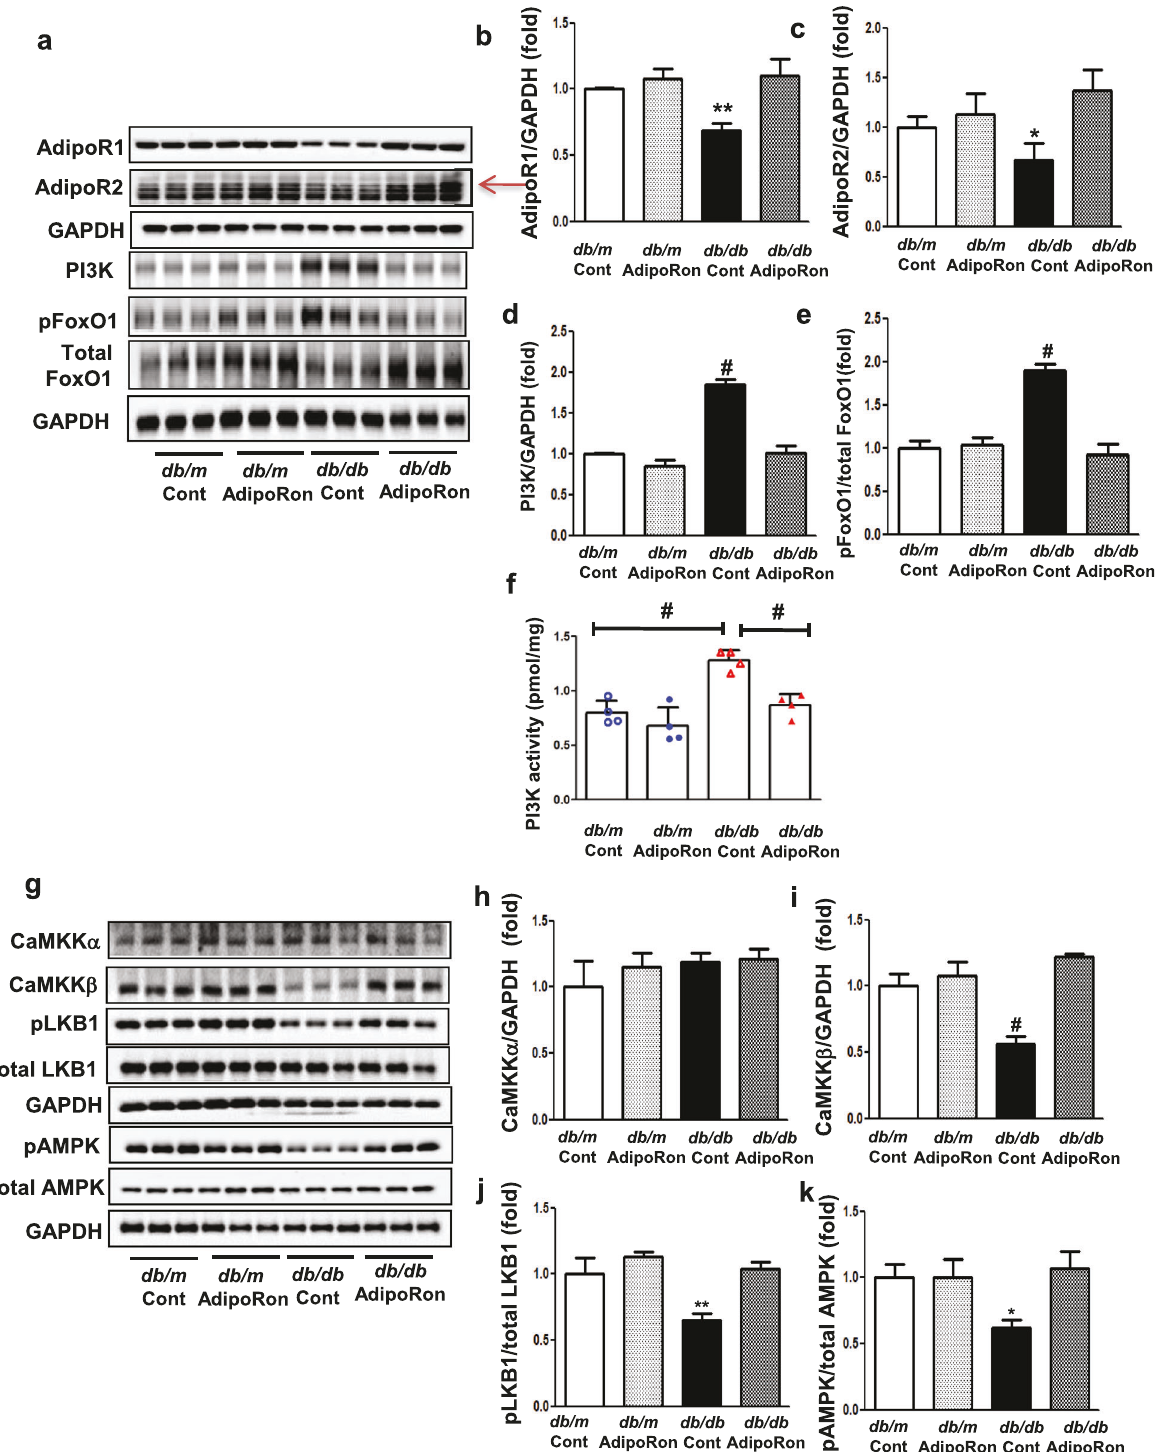
Fig. 4 Changes in the expression of adiponectin receptors and their associated downstream signaling pathways in diabetic and non- diabetic mice with or without AdipoRon treatment. a Representative images of western blotting of AdipoR1, AdipoR2, PI3K, pFoxO1, total FoxO1, and GAPDH levels. b – e Quantitative analyses of western blotting images according to groups. f Quantitative analyses of PI3K activity according to groups. g Representative images of western blotting of CaMKK α , CaMKK β , phosphorylated Ser 431 LKB1, total LKB1, phosphorylated AMPK Thr 172 , total AMPK and GAPDH levels. h – k Quantitative analyses of western blotting images according to groups. l Representative images of western blotting of PPAR α , PGC-1 α , and GAPDH levels. m , n Quantitative analyses according to groups. o Representative images of western blotting of phosphorylated ACC, total ACC, SREBP-1c, and GAPDH levels. p , q Quantitative analyses according to groups. r Representative images of western blotting of phosphorylated Akt, total Akt, phosphorylated Ser 1177 eNOS, total eNOS, and GAPDH levels. s , t Quantitative analyses according to groups. * P < 0.05, ** P < 0.01, and # P < 0.001 compared with other